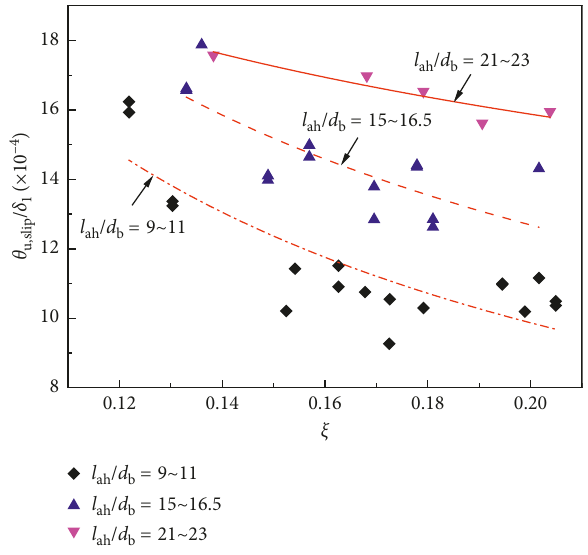
Figure 17: Effect of ξ on θ